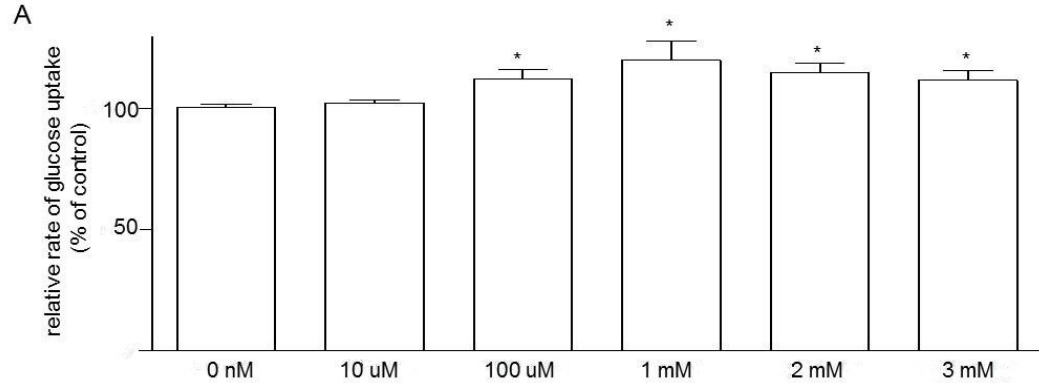
Figure 5. Cont Figure 5. Cont. Figure 5. Cont.